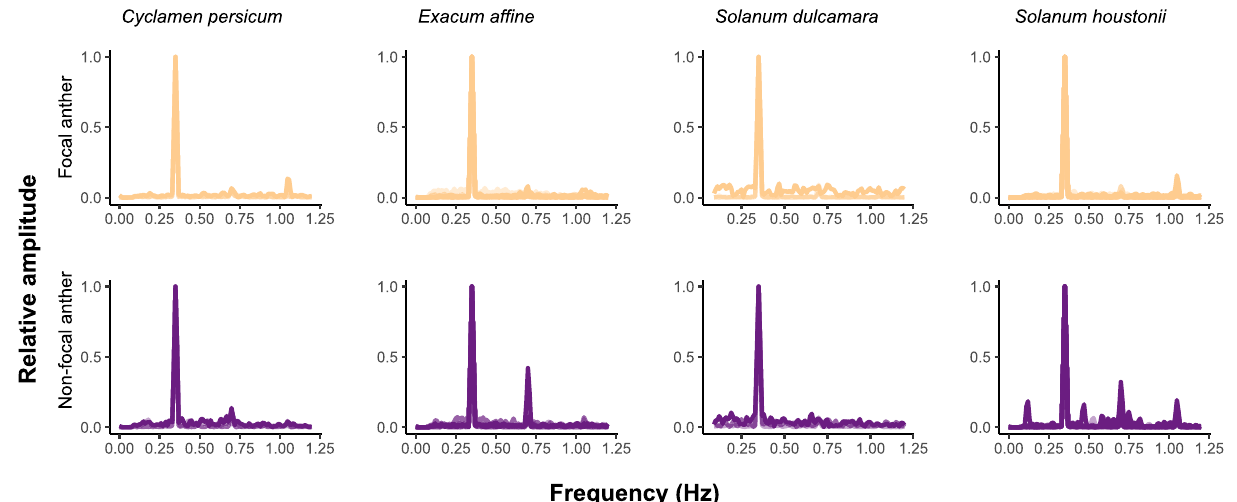
Figure 3. Frequency spectra for focal (top row) and non-focal anthers (bottom row) of four plant species in response to artificial vibrations applied in the focal anther using the vibration playback system shown in Fig. 1. The frequency of the input vibration was 350 Hz.